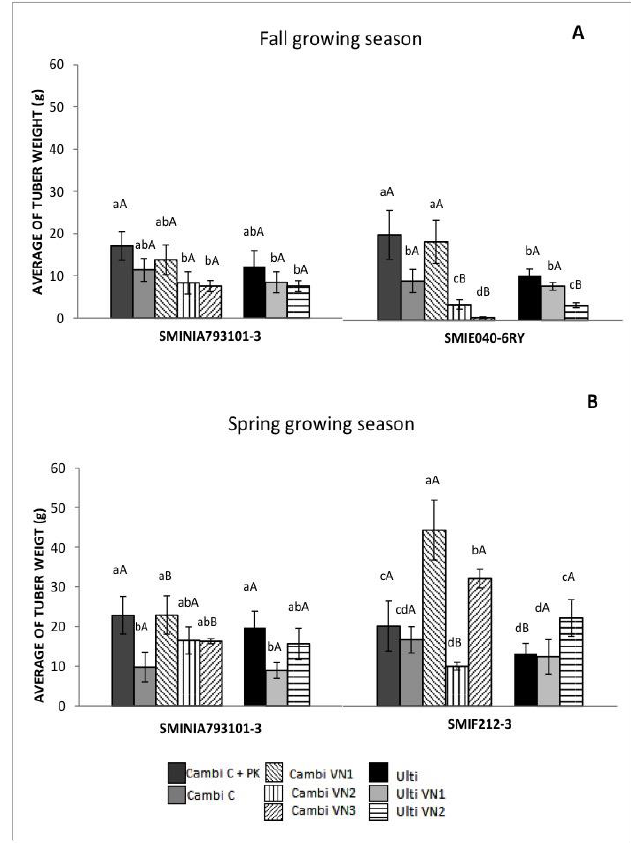
Fig. 1: Effect of increasing Cu levels on number of tubers per plant at fall (A) and spring (B) growing seasons. Data represent the mean ± S.D. of six replicates. Different lowercase letters indicate significant differences between Cu levels in the same potato genotype and growing season (p < 0.05). Different capital letters indicate sig- nificant differences between potato genotypes at the same Cu level (p < 0.05).